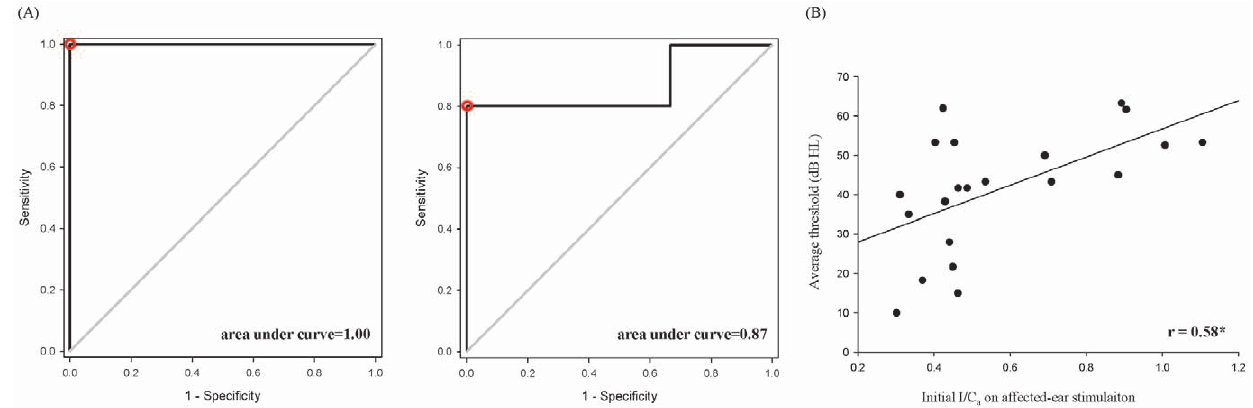
Figure 2. Prognostic effect of neuromagnetic index. ( A ) ROC curves showed the best prediction effect of I/C for the hearing improvement. Left,betweensubgroupsofcompleteandpartialrecovery , the optimal cut-off value was an initial I/C ls on affected-ear stimulation at 1.34 (area under curve 1, sensitivity 100%, specificity 100%, red circle). Right,betweensubgroupsofpartialandnorecovery , the optimal cut-off value was an initial I/C ls on healthy-ear stimulation at 0.76 (area under curve 0.87, sensitivity 80%, specificity 100%, red circle). ( B ) Relationship between ipsilateral/contralateral ratio and hearing levels. When ipsilateral/contralateral ratio were correlated to hearing levels, no significant correlation was revealed except for that between the initial I/C a on affected-ear stimulation and the fixed hearing level (r=0.58, p=0.006). r, correlation coefficient; *, p , 0.05.